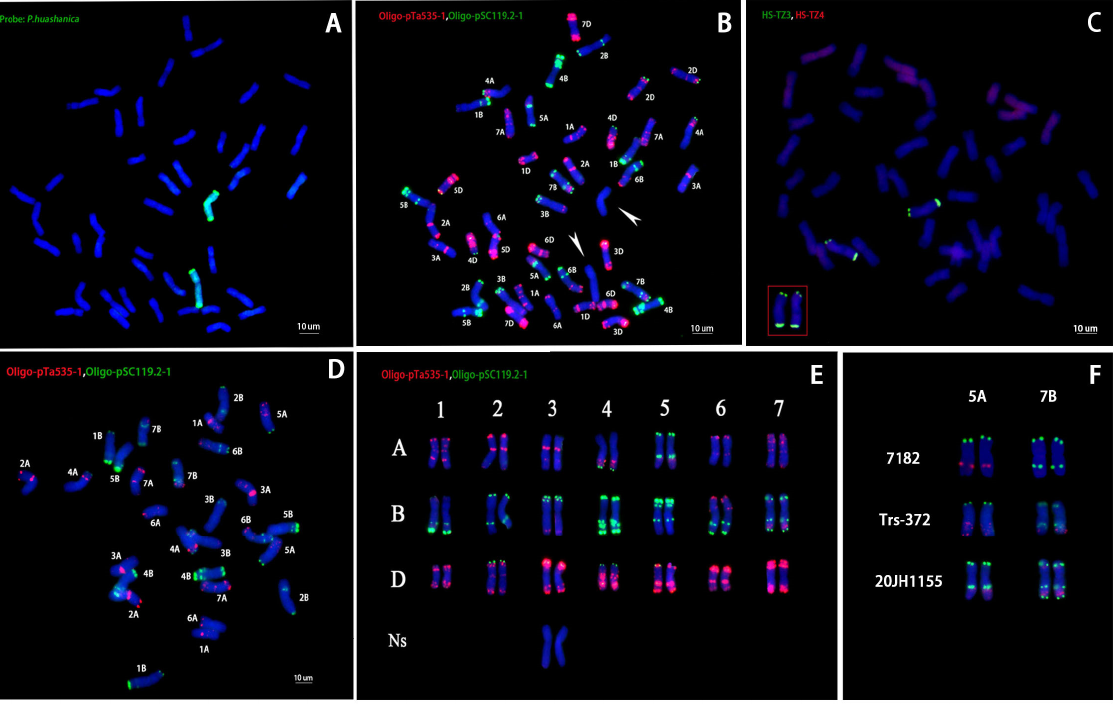
Figure 2. Cytological observation and in situ hybridization identification for chromosomes of root tip cell at mitotic metaphase of wheat- P. huashanica derivative 20JH1155. Chromosomes were dyed with counterstain DAPI (blue). ( A ) GISH analysis of 20JH1155 using P. huashanica genomic DNA as a probe (green) showed that there were 2 chromosomes of P. huashanica . ( B ) FISH karyotype using Oligo-pSc119.2 (green) and Oligo-pTa535 (red) of 20JH1155 showed that 20JH1155 contained 42 common wheat chromosomes and 2 P. huashanica chromosomes without signals (2 white arrows). ( C ) FISH karyotype using HS-TZ3 (green) and HS-TZ4 (red) of 20JH1155. The chromosomes in the red box have signals much like the 3Ns of P. huashanica. ( D ) FISH karyotype using Oligo-pSc119.2 (green) and Oligo-pTa535 (red) of Trs-372. ( E ) FISH karyotype of 20JH1155 referenced the published 7182 chromosomes. The number 1-7 meant 1-7 homoeologous, and A, B and D meant A genome, B genome and D genome of common wheat. Ns meant the genome of P. huashanica. ( F ) FISH signal comparison among 7182, Trs-372, and 20JH1155 in 5A and 7B chromosomes. There were green signals in 5AL and the end of 7BL of 20JH1155 which di ff ered from its parental wheat 7182 and Trs-372.